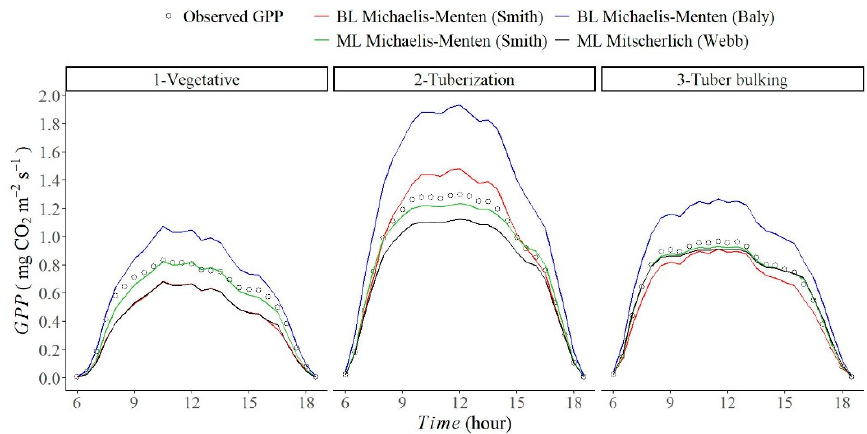
Figure 7. Half-hourly variation of gross primary production (GPP) estimated with the scaling up Big-leaf—BL (red and blue lines) and Multilayer–ML (green and yellow lines) models and with eddy covariance measurements (black line) in three different growth stages (vegetative, tuberization, tuber bulking) of potatoes ( Solanum Tuberosum L. Var. Diacol capiro). Half-hourly averages are plotted.